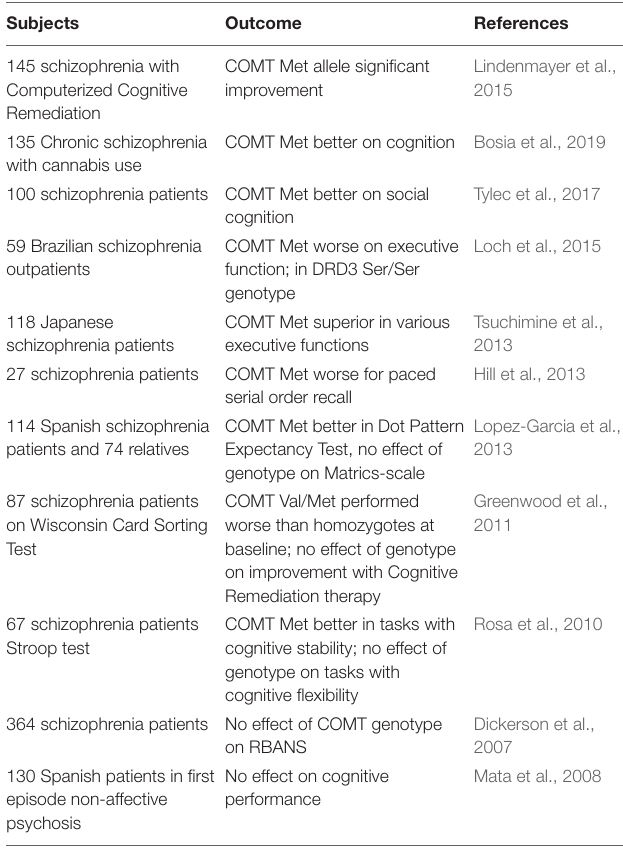
TABLE 2 | Clinical studies on the effect of COMTVal158Met genotype on cognitive outcome in